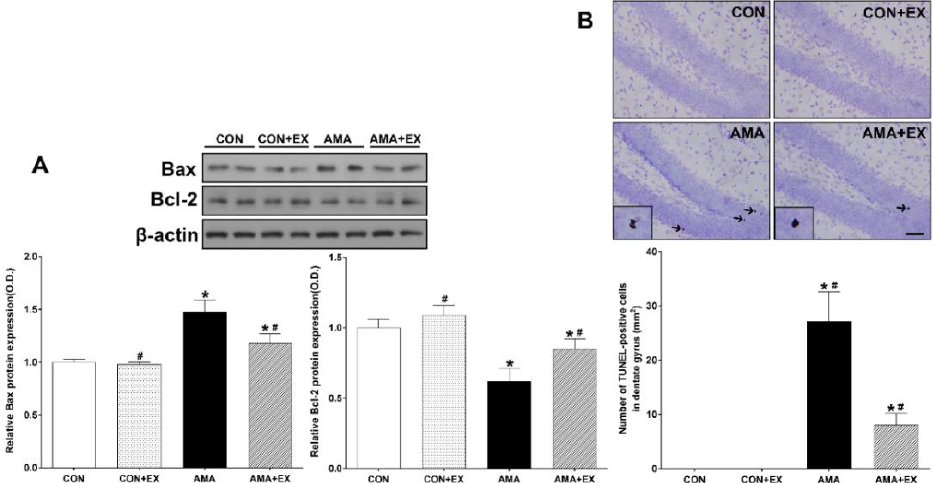
Figure 4. Effects of exercise on apoptosis ( A ) and cell death ( B ) in the hippocampus and dentate gyrus of offspring from mothers with advanced maternal age (AMA). Representative photomicrographs and data for TUNEL-positive cells are shown. The scale bar represents 50 µm. CON: offspring from the control group; CON + EX: offspring from the control and exercised group; AMA: offspring from the advanced maternal age group; AMA + EX: offspring from the advanced maternal age and exercised group. Data are expressed as means ± standard error of the mean (SEM). * p < 0.05 compared to the CON group. # p < 0.05 compared to the AMA group.